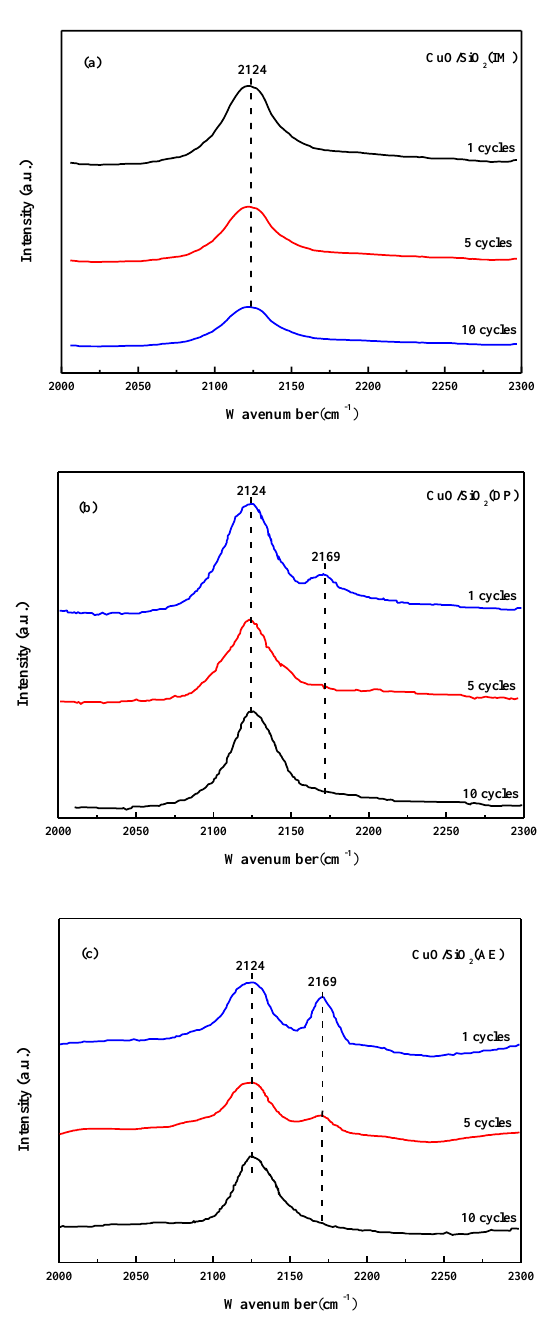
Figure 9. CO-IR spectra of the used CuO/SiO 2 catalysts. ( a ) CuO/SiO 2 (IM), ( b ) CuO/SiO 2 (DP), and ( c ) CuO / SiO 2 CuO/SiO 2 (AE).